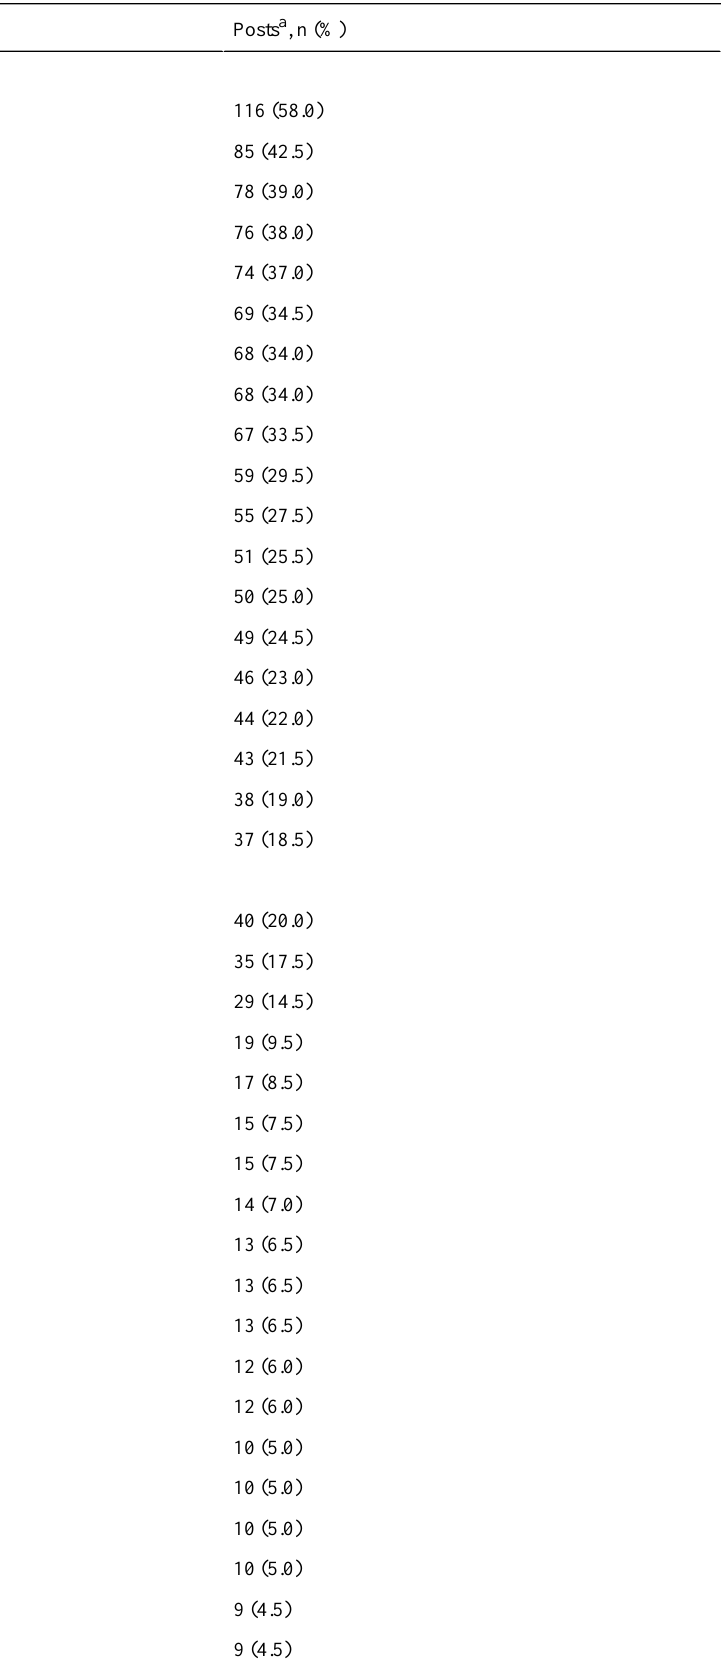
Table 1. Top 20 hashtags in 200 pro-vaping and 200 vaping-warning